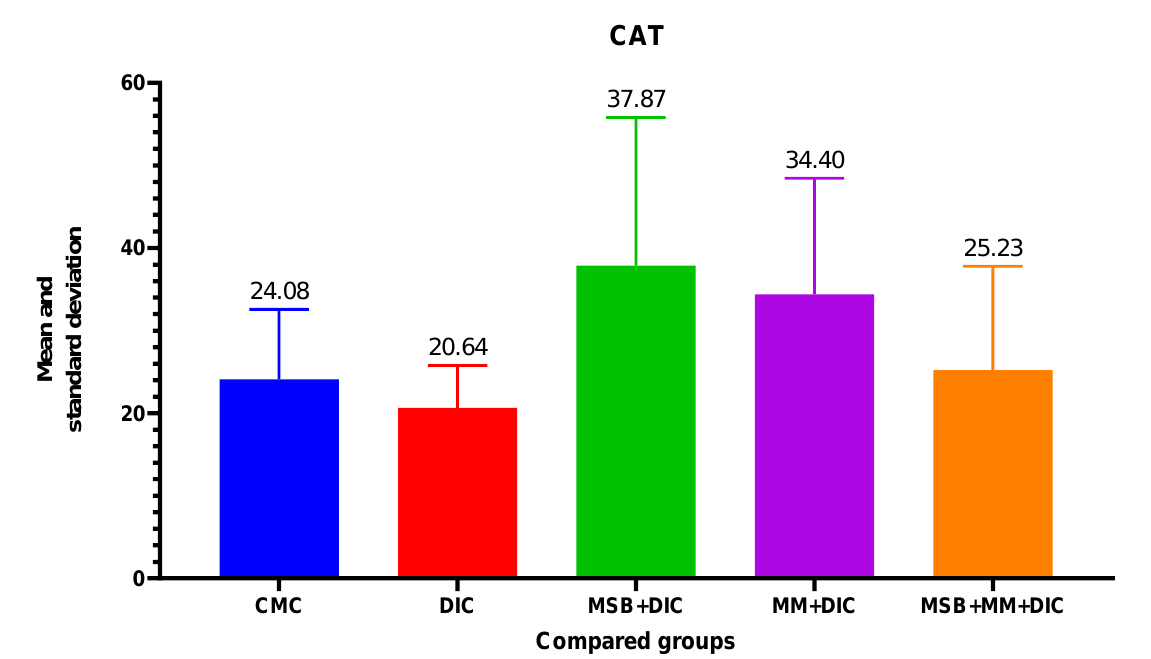
Figure 8. Mean value and standard deviation of CAT between analyzed groups. Group I-CMC, negative control group; group II-DIC, disease control group; group III-MSB+DIC, group receiving MegaSporeBiotic; group IV-MM+DIC, group receiving MegaMucosa; group V-MM+MSB+DIC, group receiving MegaSporeBiotic and MegaMucosa.